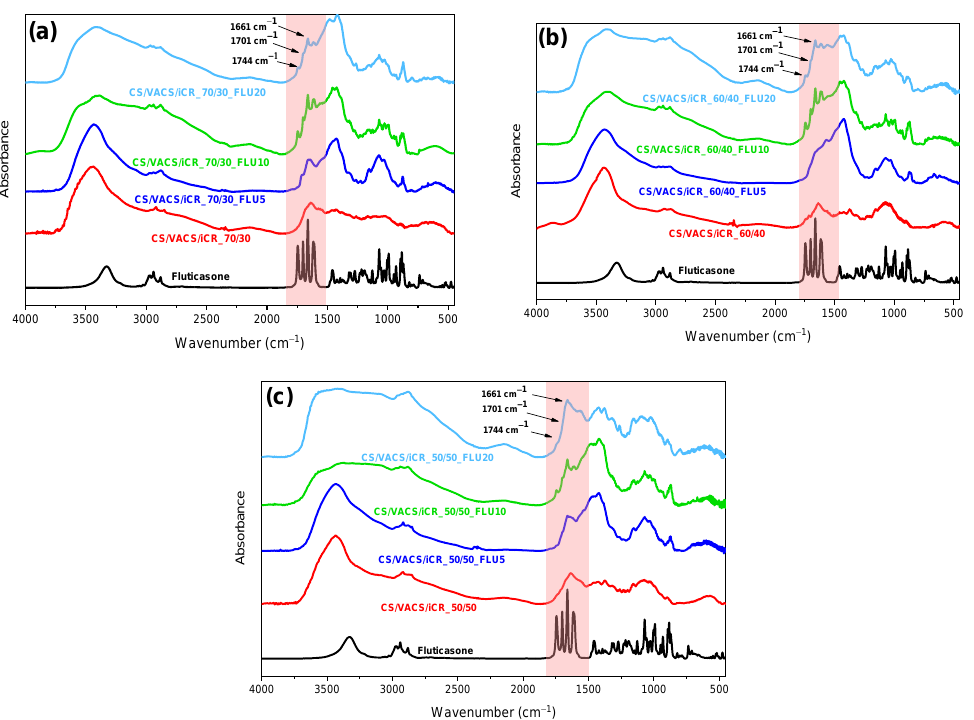
Figure 8. FTIR spectra: ( a ) CS/VACS/iCR 70/30, ( b ) CS/VACS/iCR 60/40, and ( c ) CS/VACS/iCR 50/50 containing FLU in different ratios of 5%, 10% and 20% w / w .